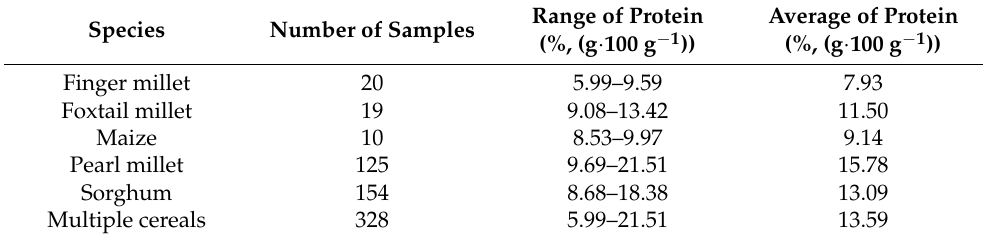
Table 1. Results of laboratory estimation of protein content in multiple cereal samples used in the study. The table indicates the range and average grain protein content %, g · 100 g − 1 ), along with the number of samples used per